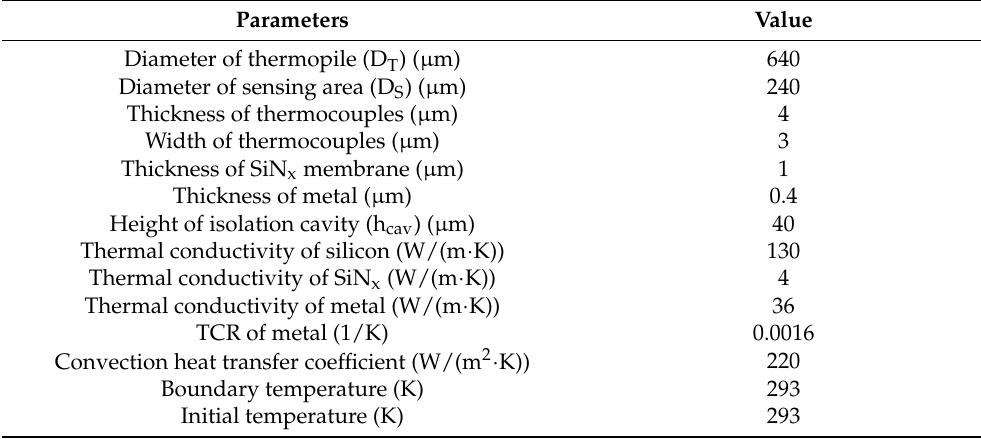
Table 1. Model structural dimensions and material thermophysical parameters.